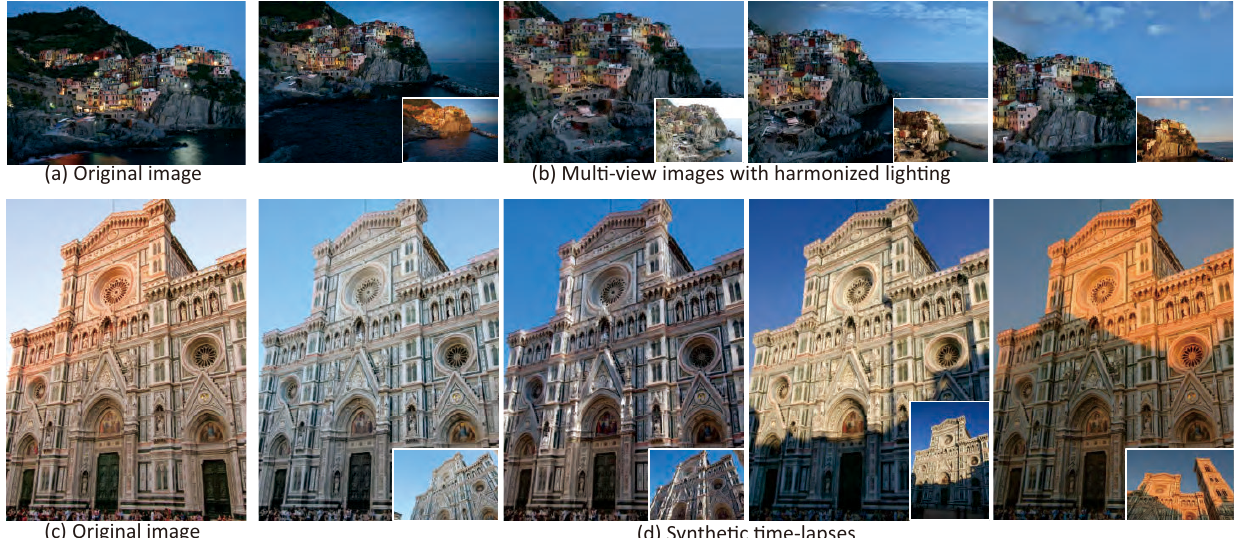
Fig. 8 Our method can be used for harmonizing a photo collection with multi-view images (b) and hallucinating time-lapses (d). The insets represent source images in (b) and target images with desired lighting in (d). Additional results are available in the supplementary video in the ESM.